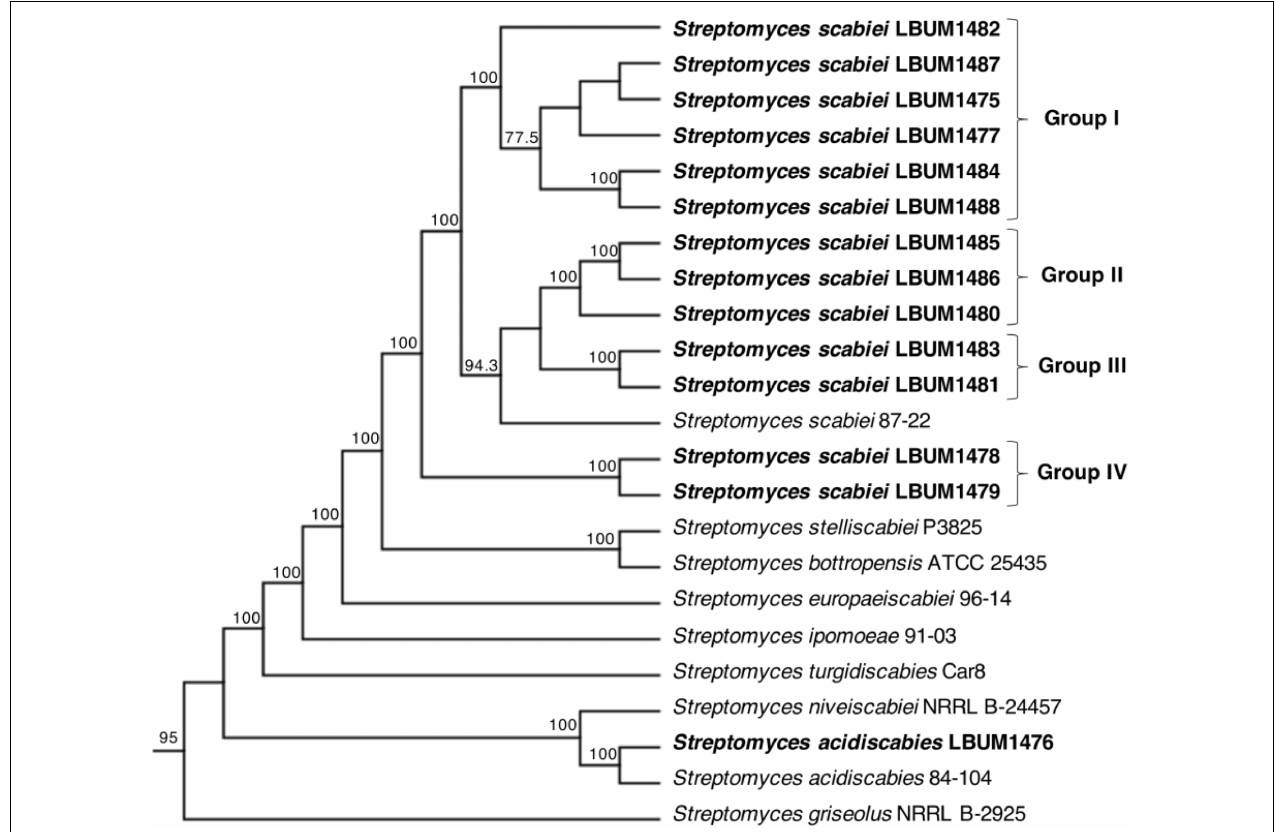
FIGURE 1 | Neighbor-joining phylogeny tree of 14 Streptomyces strains used in this study (bold) and eight phytopathogenic Streptomyces spp. reference strains. S. griseolus NRRL B-2925 was used as an outgroup. The Neighbor-Joining tree is based on the alignment of the core-genomes of these organisms (corresponding to 1577 CDSs per genome). Four S. scabiei groups were distinguished. Only bootstrap values higher than 60% are displayed. Branches are presented as a cladogram for improved